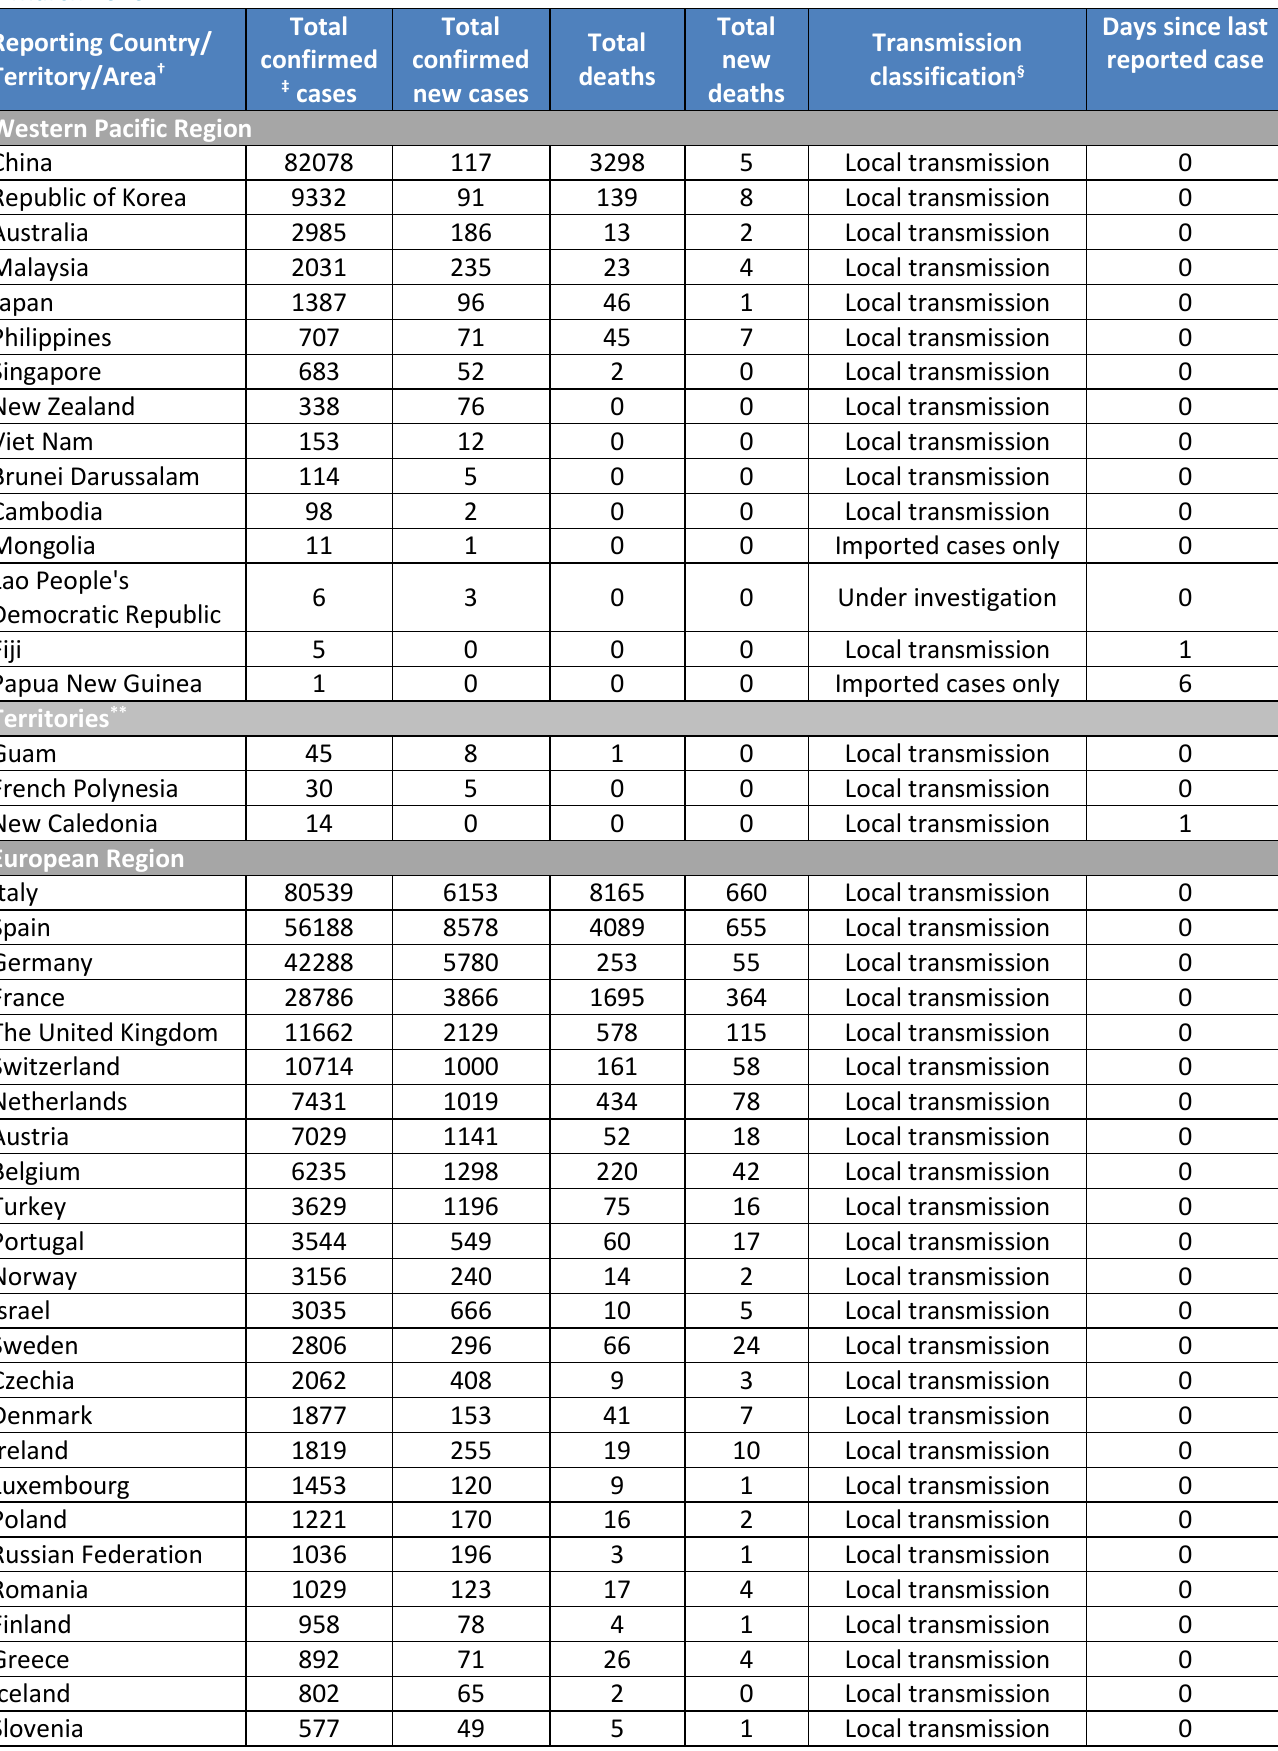
Table 2. Countries, territories or areas with reported laboratory-confirmed COVID-19 cases and deaths. Data as